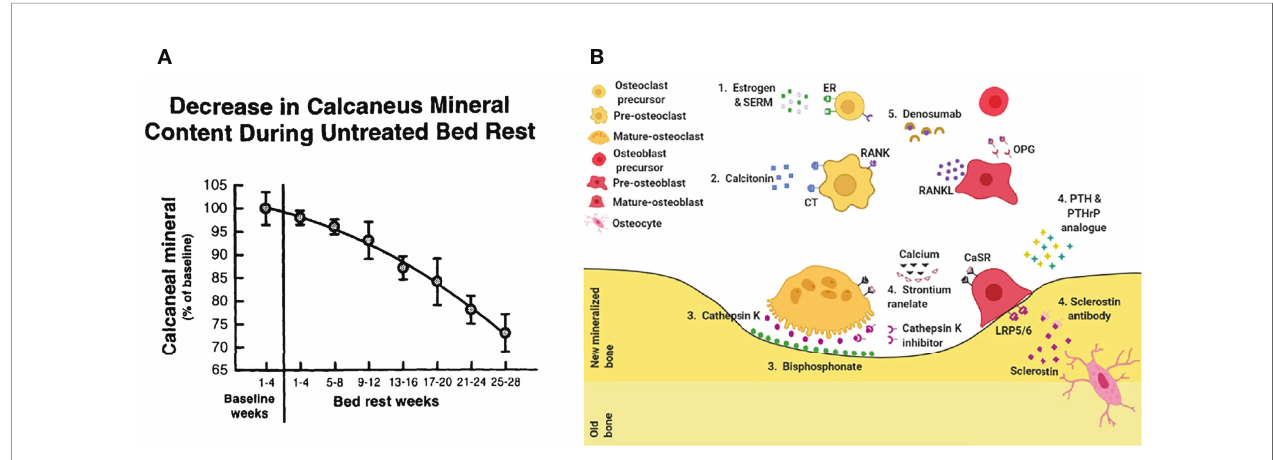
FIGURE 2 | Treat osteoporosis. (A) Bedridden leads to accelerated bone loss (23). (B) Current drug treatment. 1. Estrogen & SERM, 2. Calcitonin, 3. Bisphosphonate, 4. Sclerostin antibody, 5. Denosumab (24).